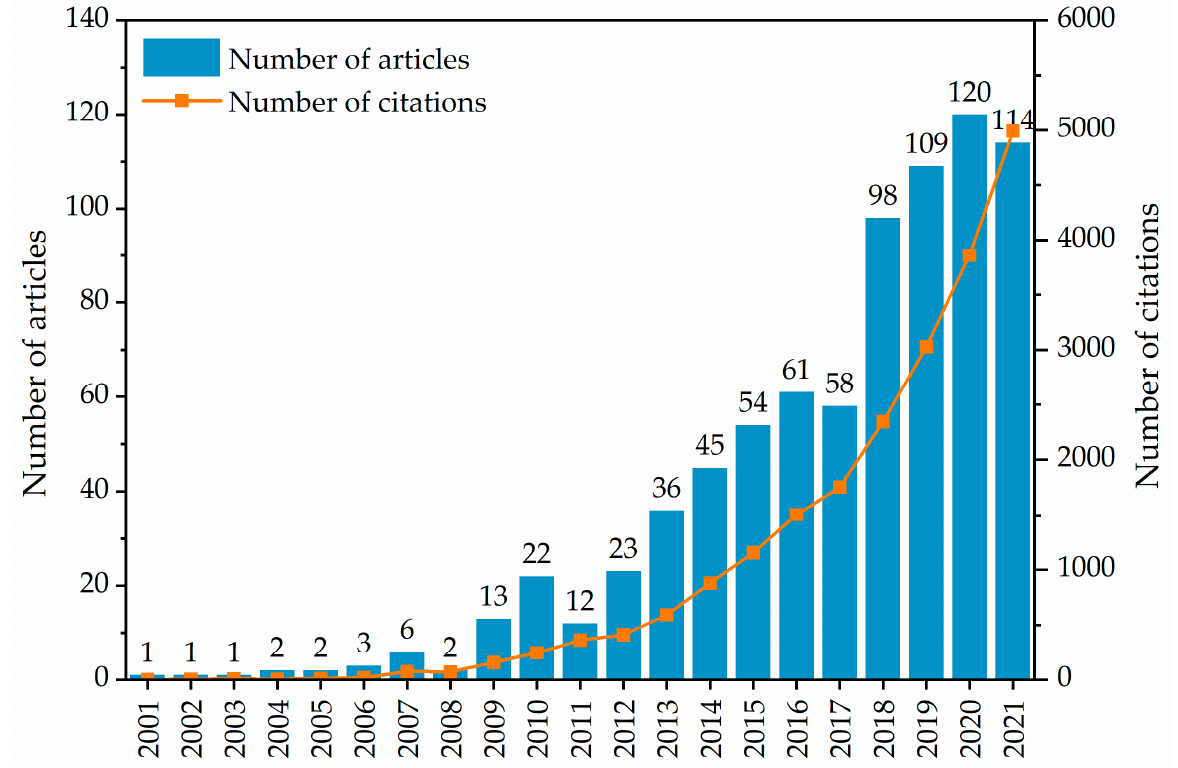
Figure 1. Annual total articles and citations from 2001 to 2021.